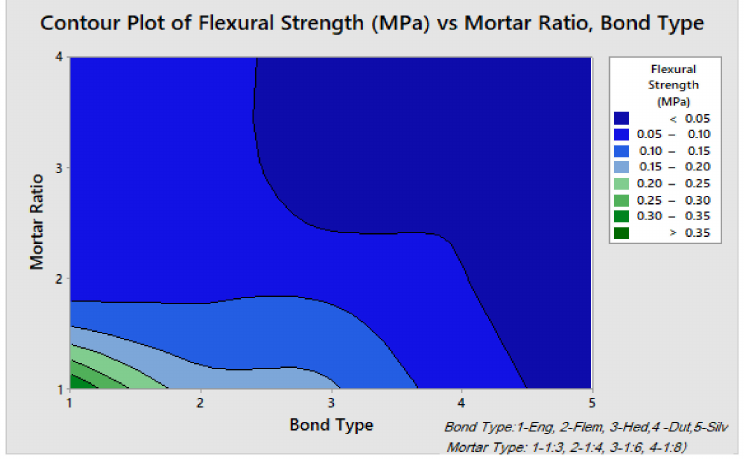
Figure 9. Flexural strength with reference to bond type and mortar